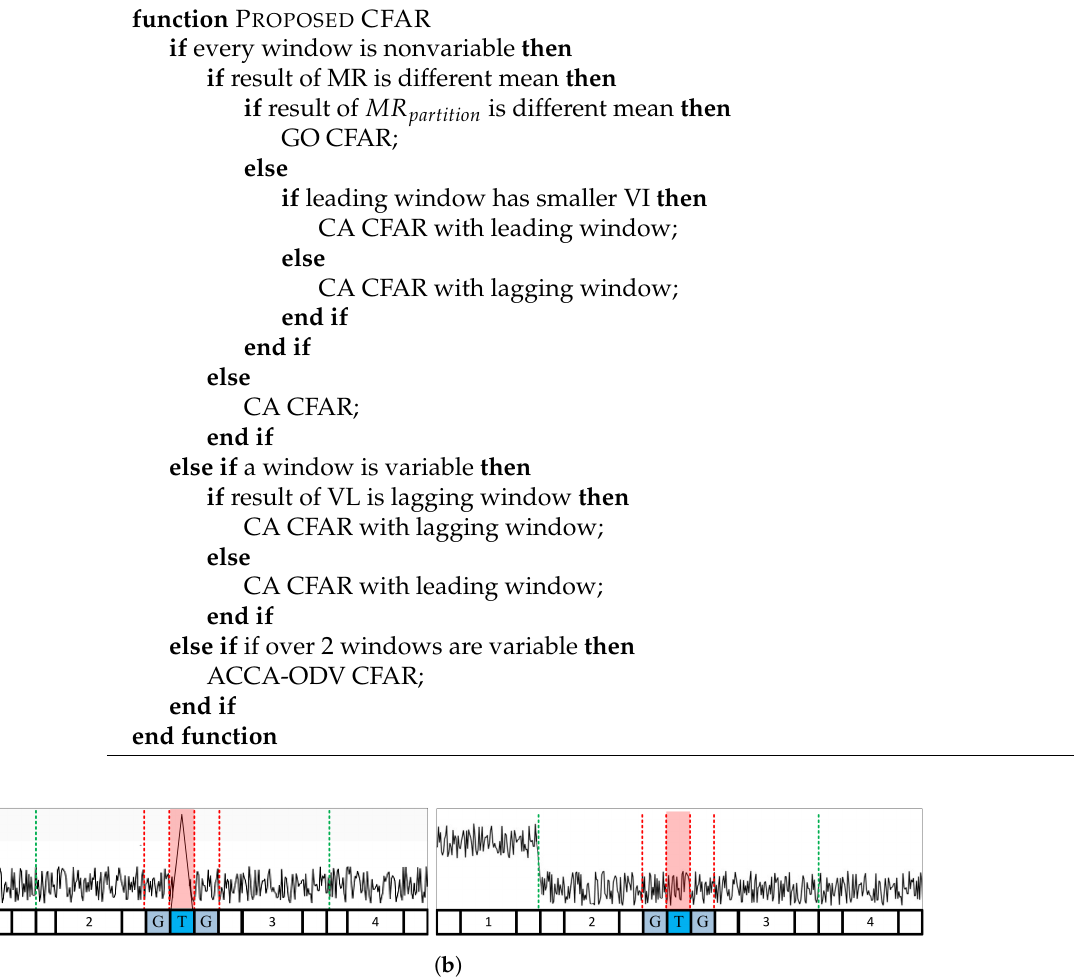
Algorithm 1 Pseudocode of the Proposed CFAR.